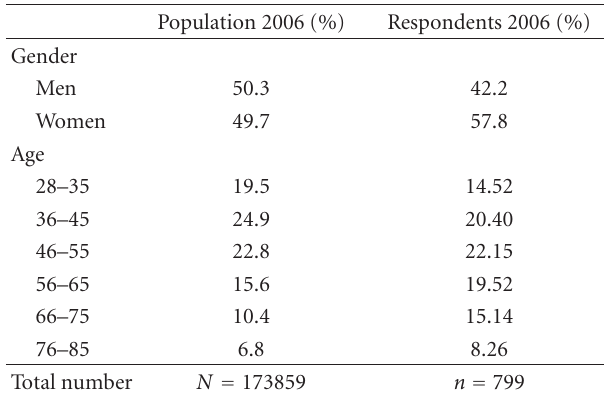
Table 2: Study population. Age and sex distribution.